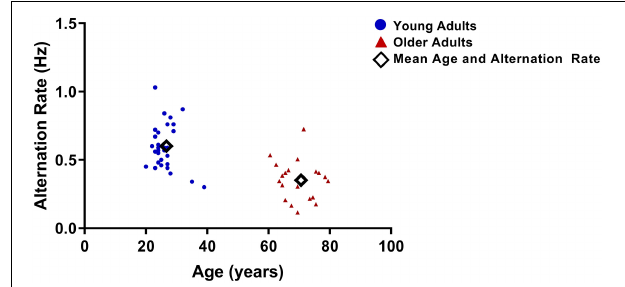
FIGURE 5 | Alternation rates (AR) for each participant vs. age. AR were significantly lower for older adults.